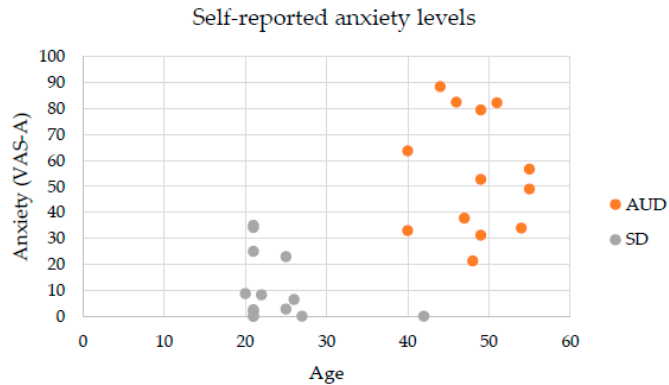
Figure 4. Self-reports of total mean anxiety in AUD and social drinkers (SD) groups.